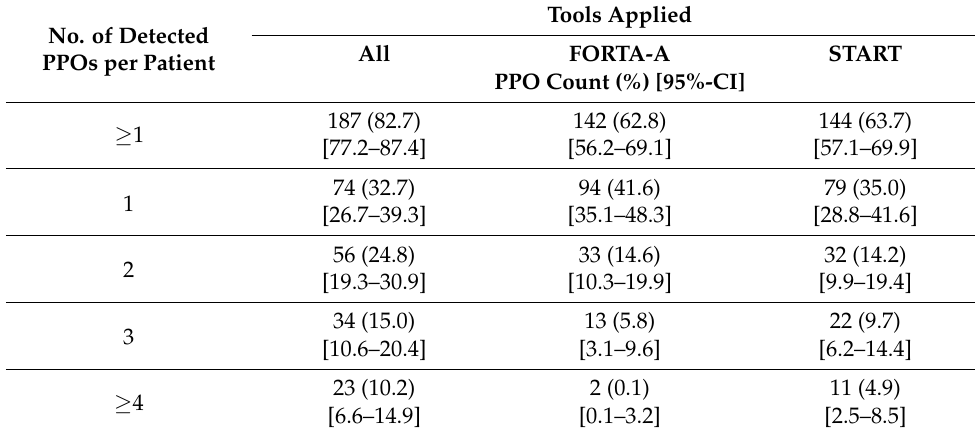
Table 4. Prevalence of potentially inappropriate medication (PIM) within the study population ( n =